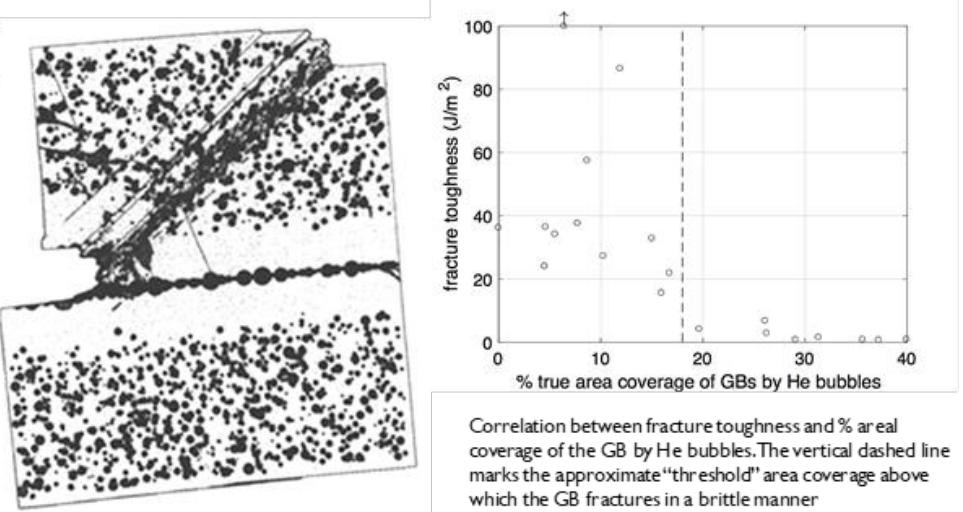
Figure 16. Calculated fracture toughness of irradiated Inconel X-750 as a function of % area coverage by cavities. Courtesy, Demkowicz, M.J.